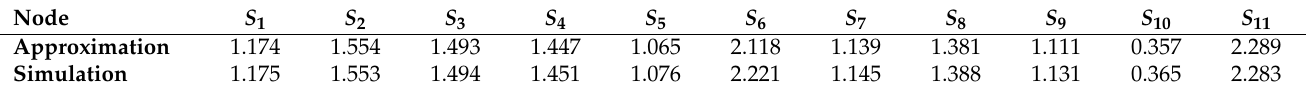
Table 1. Average numbers of customers in the nodes.